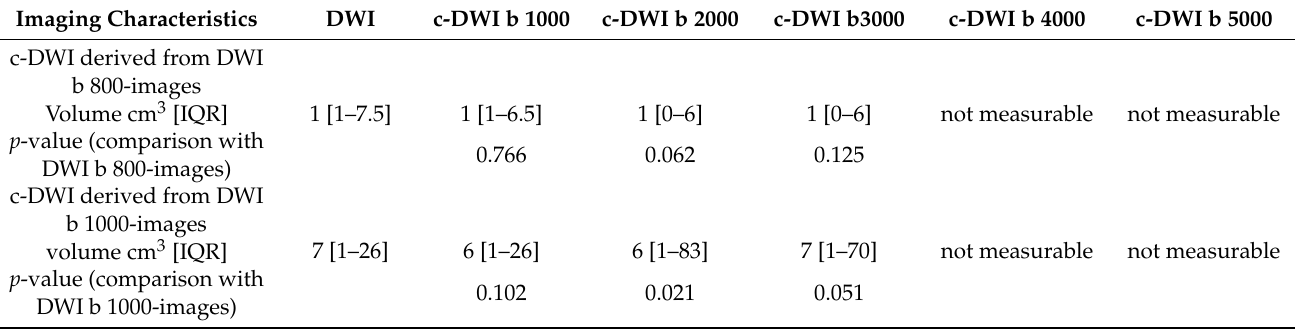
Table 4. Comparison of lesion volumes between acquired DWI-images and calculated